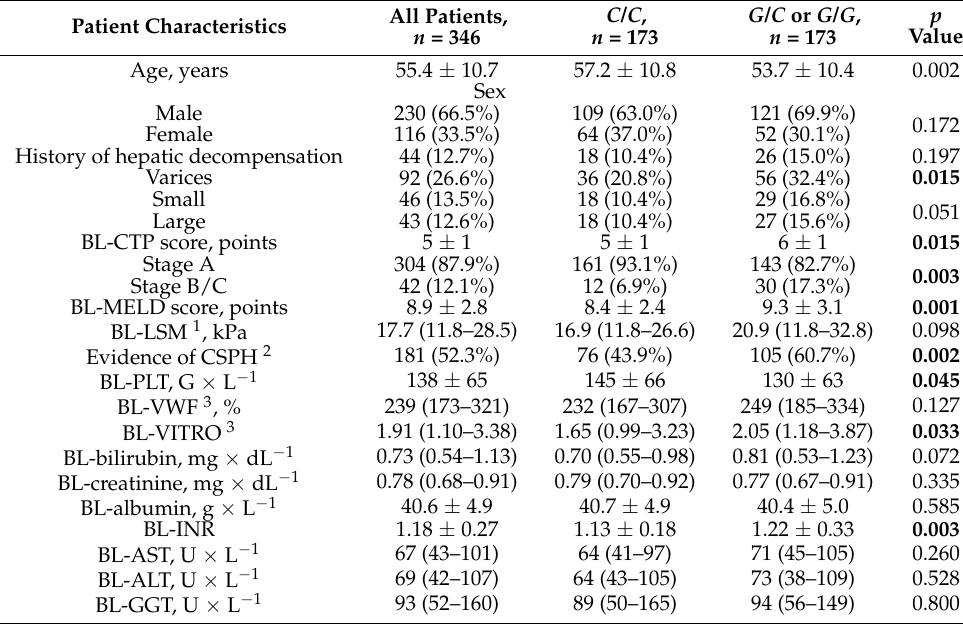
Table 1. Patient characteristics in the overall cohort (cohort B) and comparison of patients with the PNPLA3 rs738409 G-allele, or without. Abbreviations: ALT alanine aminotransferase, AST aspartate aminotransferase, BL baseline, CSPH clinically significant portal hypertension, CTP Child–Turcotte– Pugh score, GGT gamma-glutamyltransferase, INR international normalized ratio, LSM liver stiffness measurement, MELD model for end-stage liver disease, PLT platelet count, PNPLA3 patatin-like phospholipase domain-containing protein 3, VITRO von Willebrand factor/platelet count ratio, VWF von Willebrand